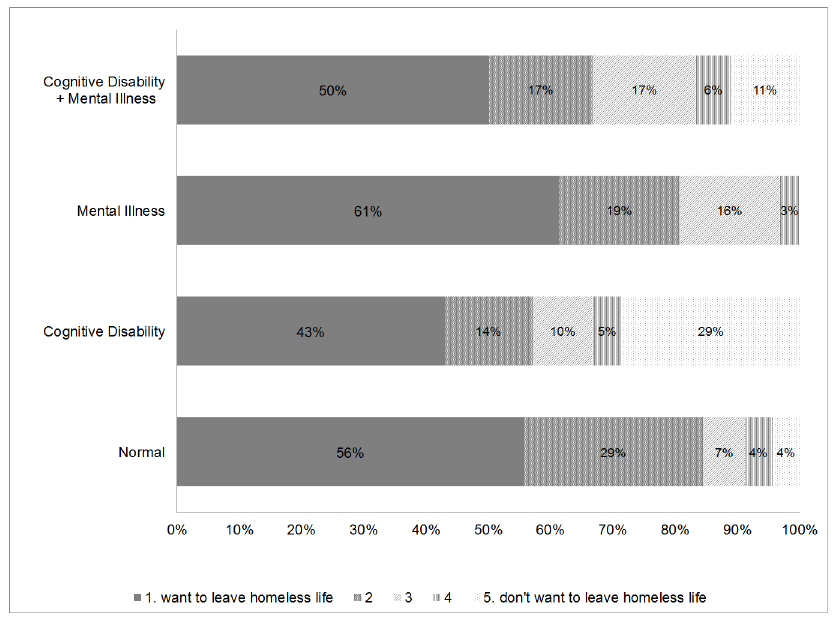
Fig 2. Responses to the question, “ Would you like to leave your homeless life? ” across the four participant groups.